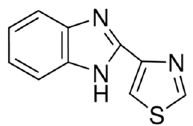
Figure 1. Molecular structure of thiabendazole used as a positive control in this study.